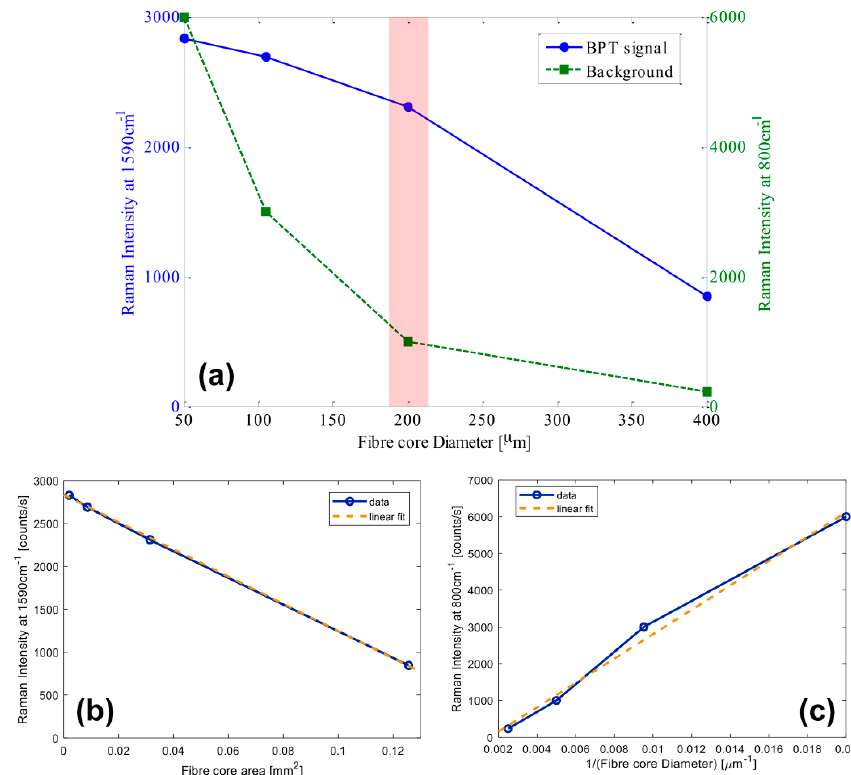
Figure 8. ( a ) Raman intensities for the band at 1590 cm − 1 and at 800 cm − 1 , respectively versus the core diameter ( b ) Raman intensity for the BPT band at 1590 cm − 1 and linear fit versus fiber core area ( c ) Raman intensity for the silica band at 800 cm − 1 and linear fit versus the inverse of fiber core diameter.